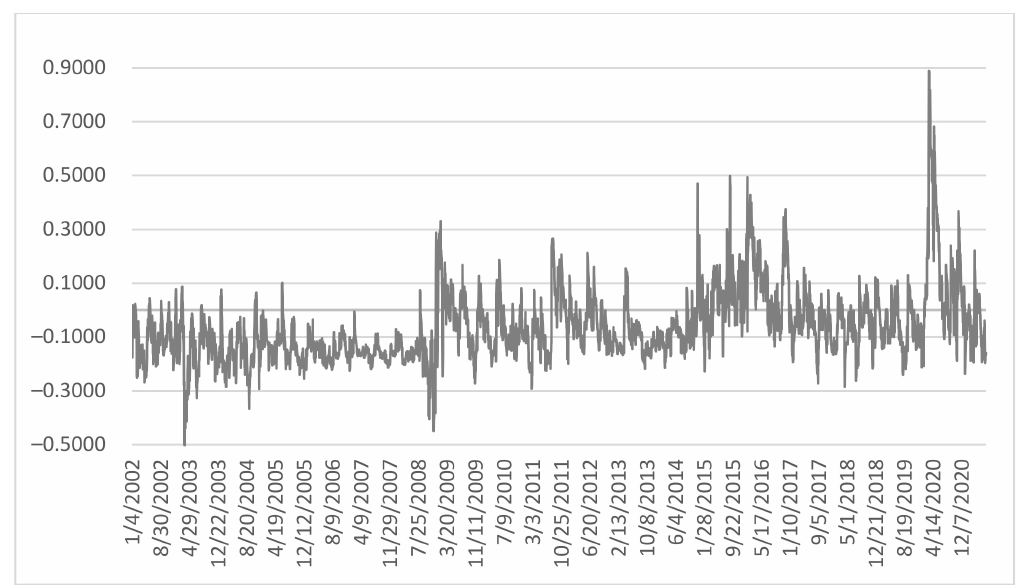
Figure 5. Estimation of the dynamic conditional correlation from model DCC(1,1) GARCH with the multivariate Student’s-t errors, between WTIF and NBSABIS.